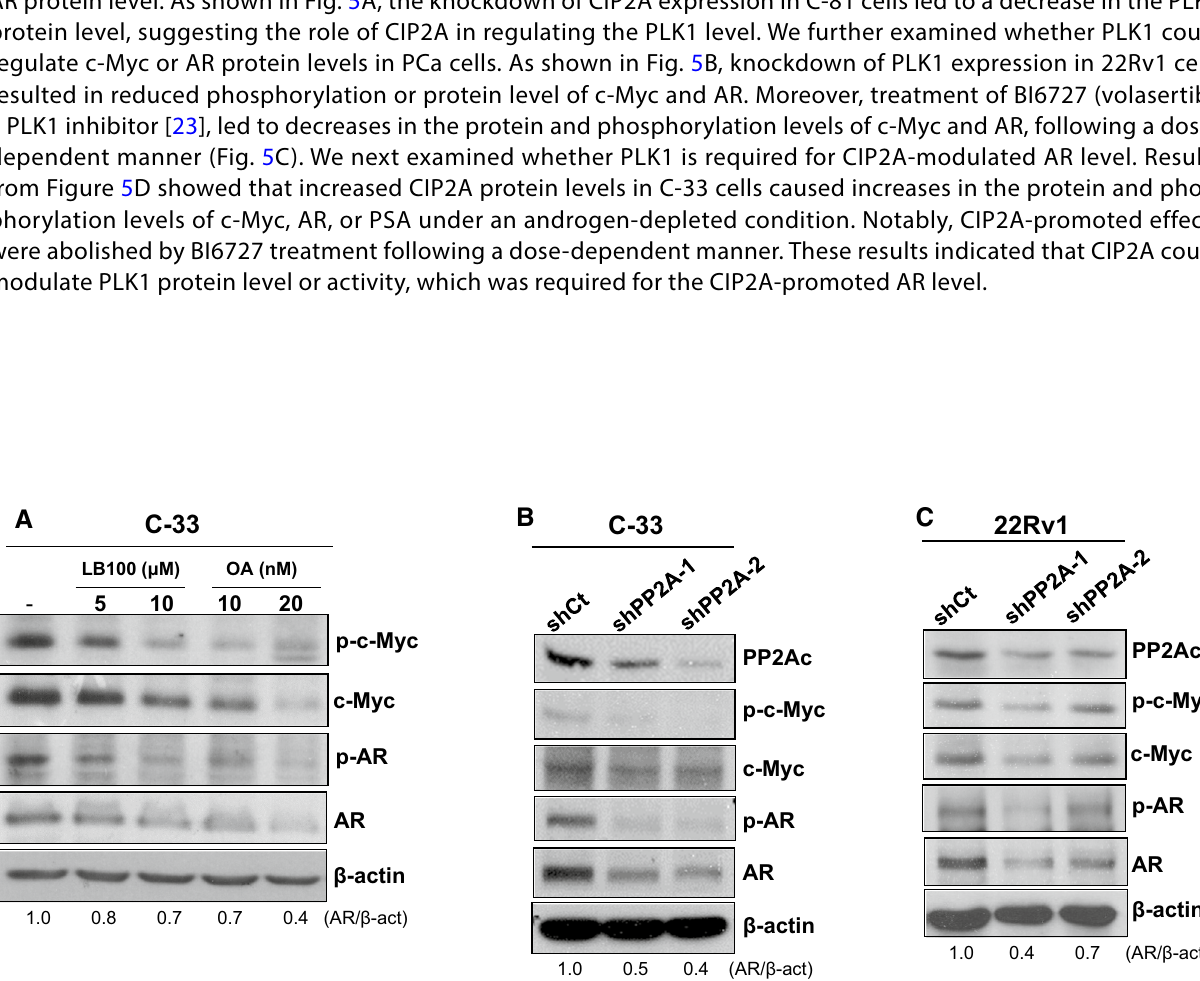
Fig. 4 Effects of inhibiting or knocking down PP2Ac on the protein levels of c-Myc and AR in PCa cells. A LNCaP C-33 cells are incubated with 5 μM or 10 μM of LB100, or 10 nM or 20 nM of okadaic acid (OA) for 24 h. Subsequently, the total lysates are prepared for immuno- blotting. B C-33 or C 22Rv1 cells infected with viruses carrying the LacZ -targeted shRNA (shCt) or PPP2CA -targeted shRNAs (shPP2A-1 or shPP2A-2) are harvested for western blot